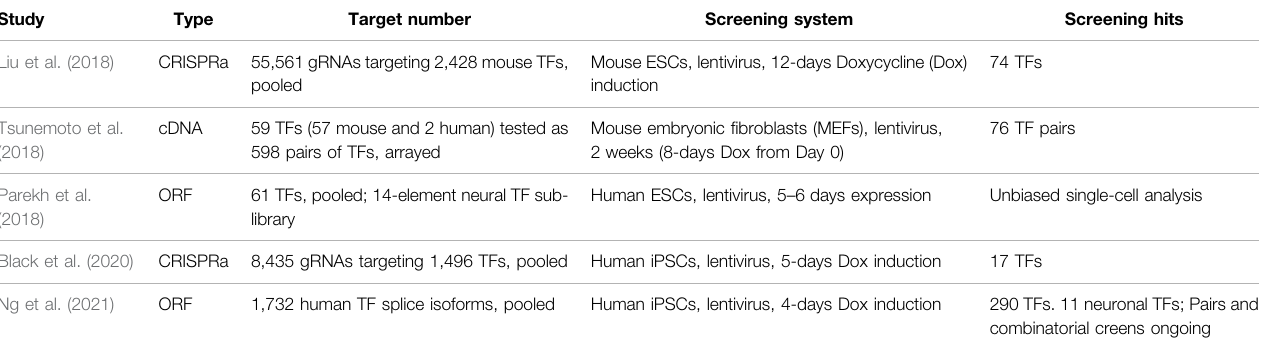
TABLE 1 | Examples of multiplexed TF screening for neuronal